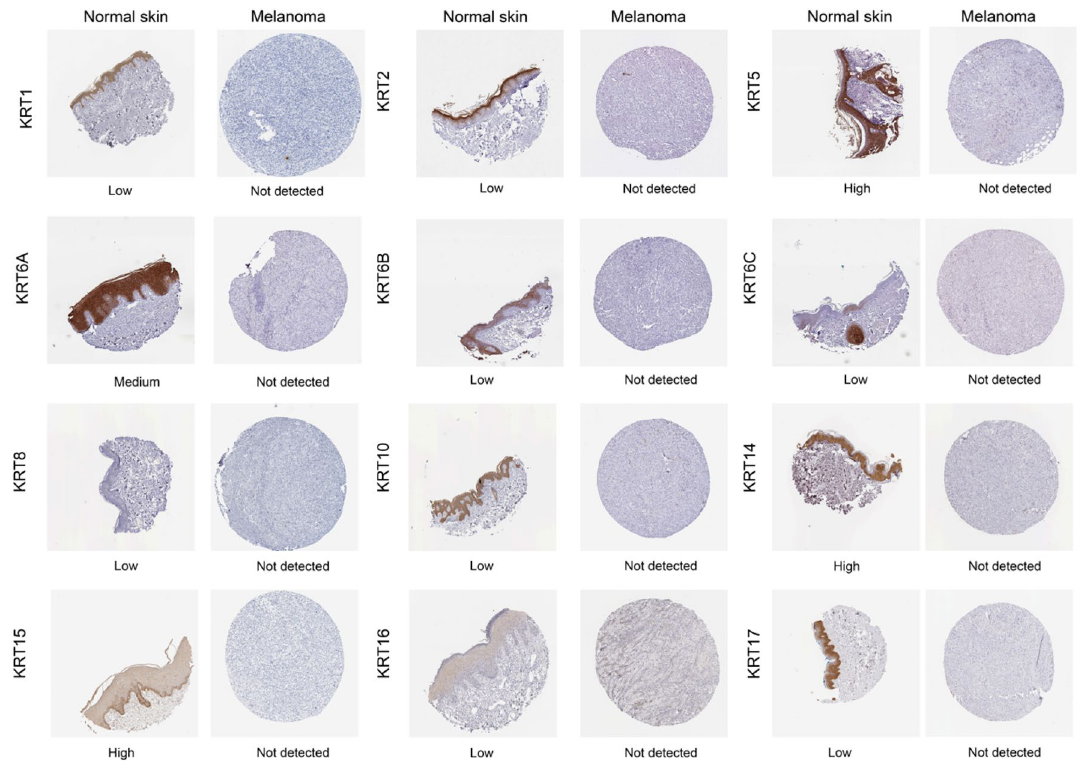
Figure 5. Immunohistochemical staining for protein expression of KRT s in tissues from patients with SKCM and normal